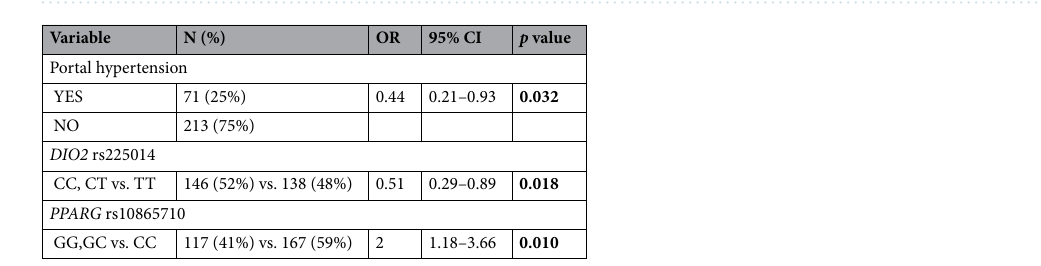
Figure 1. Graphs showing genotype distribution of DIO2 rs225014 ( A ), PPARG rs10865710 ( B ), and TBX21 rs4794067 ( C ) in patients with different fibrosis scores.